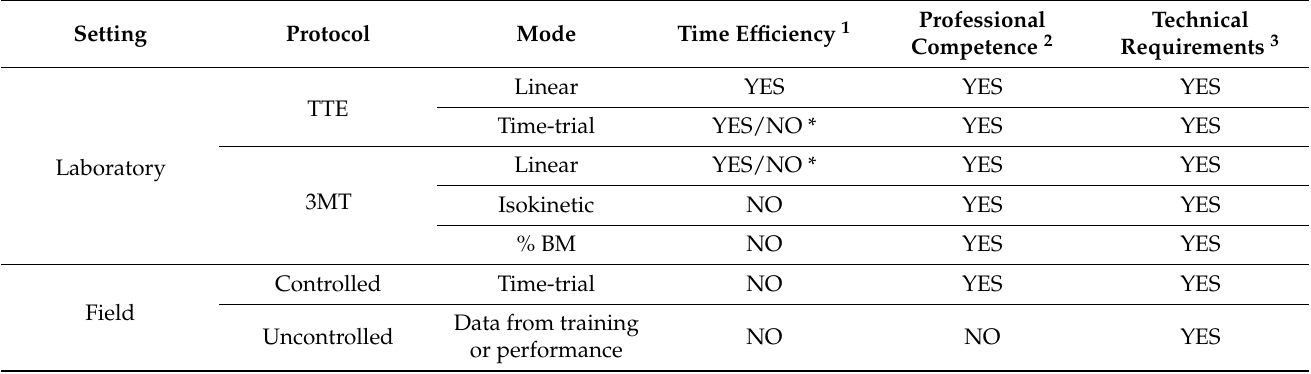
Table 3. Summarization and evaluation of individual tests according to given